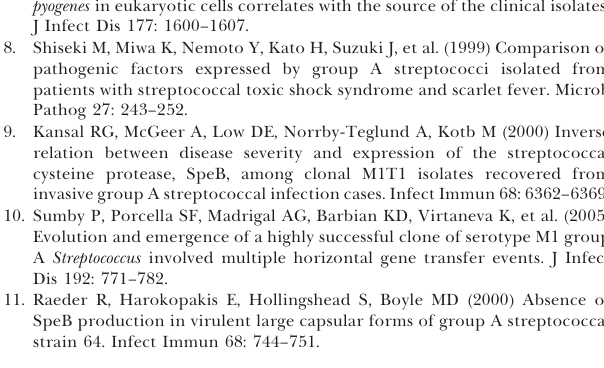
Figure S1. Global Transcriptome Variation between Clinical ITP and PTP GAS Strains The x-axis represents the whole genome sequence of contemporary M1 GAS strain MGAS5005. The y-axis represents the mean relative increase or decrease in gene transcription for the three clinical ITP strains in relation to that observed for the six clinical PTP strains. The dashed green lines represent 6 2-fold transcriptional difference. Virulence factors/regulators transcribed . 2-fold by ITP strains are colored red. Virulence factors/regulators transcribed . 2-fold by PTP